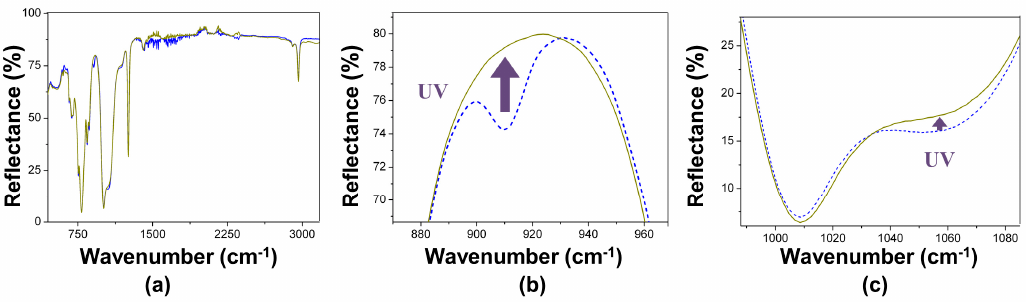
Figure 6. FTIR-ATR spectra of PDMS films exposed to Br 2 vapours before (…) and after ( - ) UV irradiation: ( a – c ) correspond to zooms of different spectral regions.